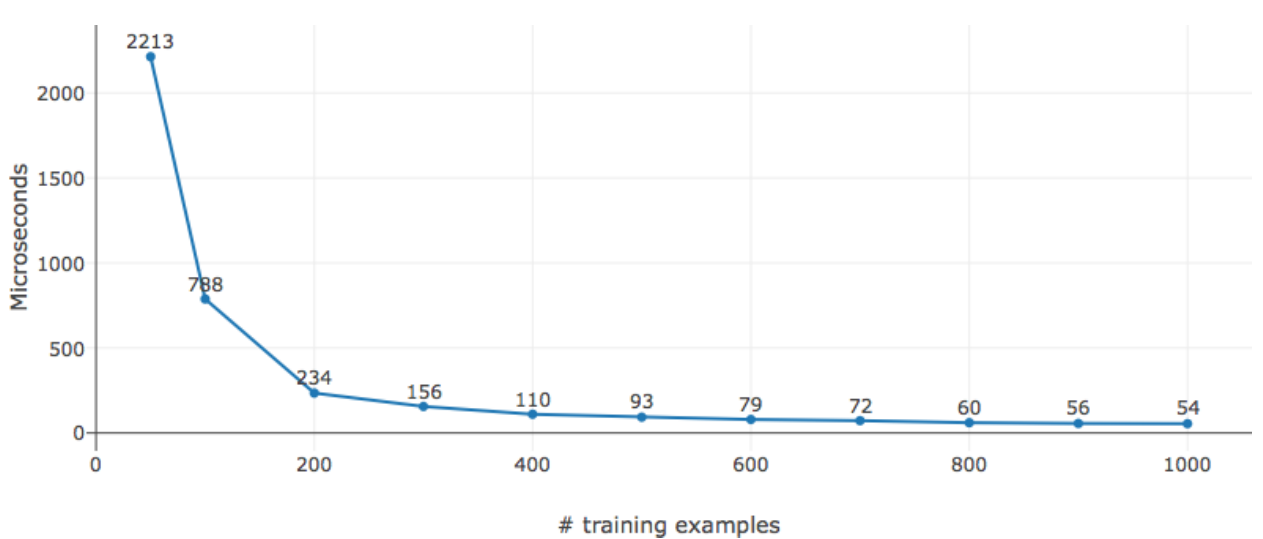
Figure 13. Time for Gram matrix generation.